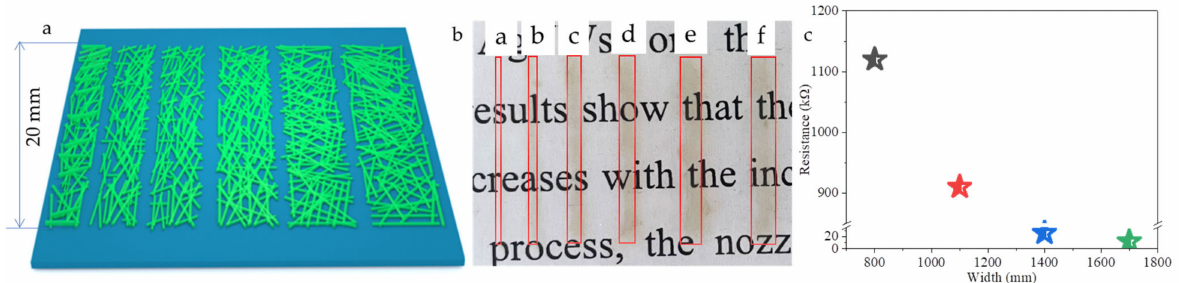
Figure 11. Schematic ( a ) and photographs ( b ), and resistance ( c ) of AgNWs patterns with a size of 20 mm and width of 200 µ m, 500 µ m, 800 µ m, 1100 µ m, 1400 µ m, and 1700 µ m,